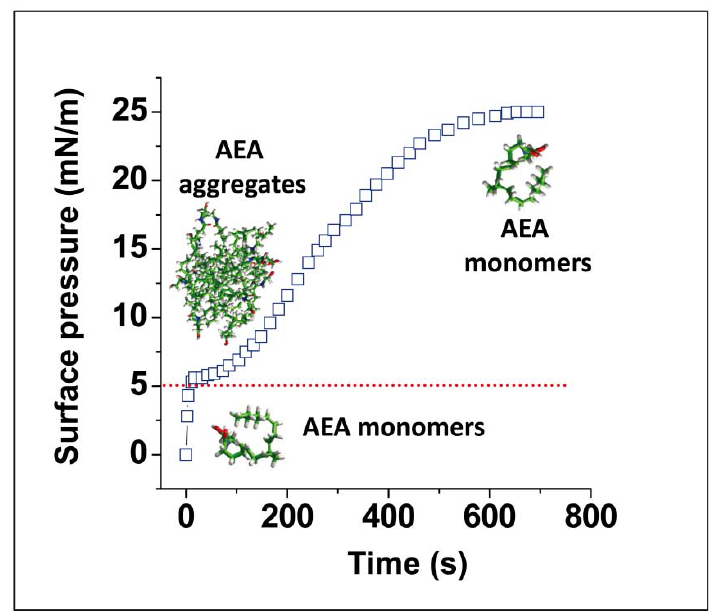
Figure 3. Surface activity of AEA monomers and aggregates. Anandamide is injected in pure water and its dissolution is assessed by surface pressure measurements using a Langmuir microtensiometer. Monomers immediately reach the air–water interface (first phase, sharp increase) whereas aggregates deliver AEA monomers very slowly (second phase, sigmoid curve) [28].